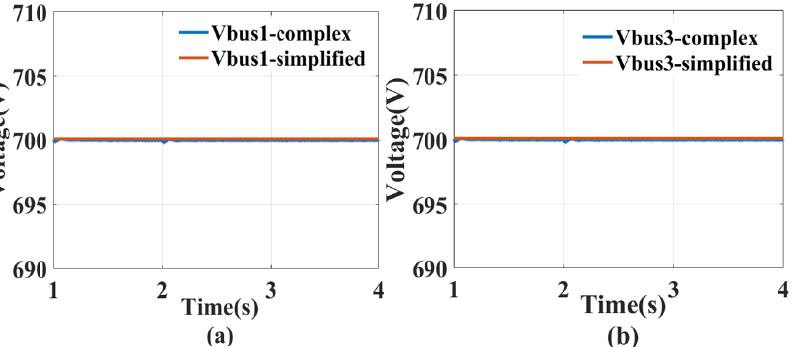
Figure 8. The bus voltage comparison for Bus 1 and Bus 3, which are connected to battery systems: ( a ) the comparison for Bus 1 and ( b ) the comparison for Bus